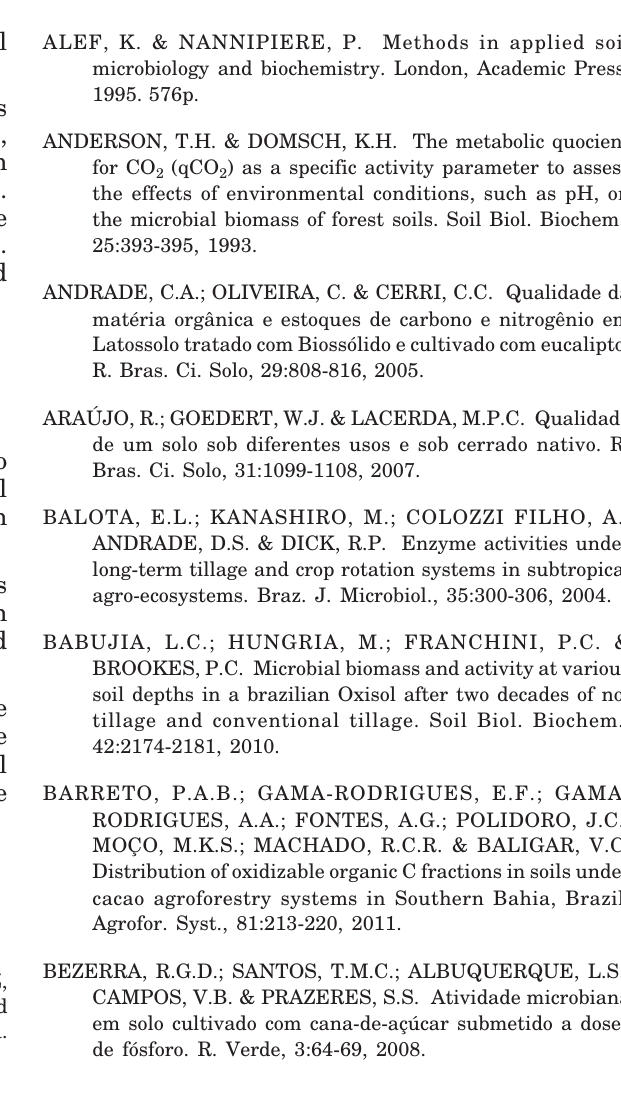
MBC: microbial carbon; BR: basal respiration; qCO : metabolic quotient; TOC: total organic carbon; qMic: microbial quotient; 2 Phos: Acid phosphatase; F1, F2, F3, and F4 oxidizable fractions of organic matter. *, ** and *** significant at 5, 1 and 0.1 %, respectively; ns :